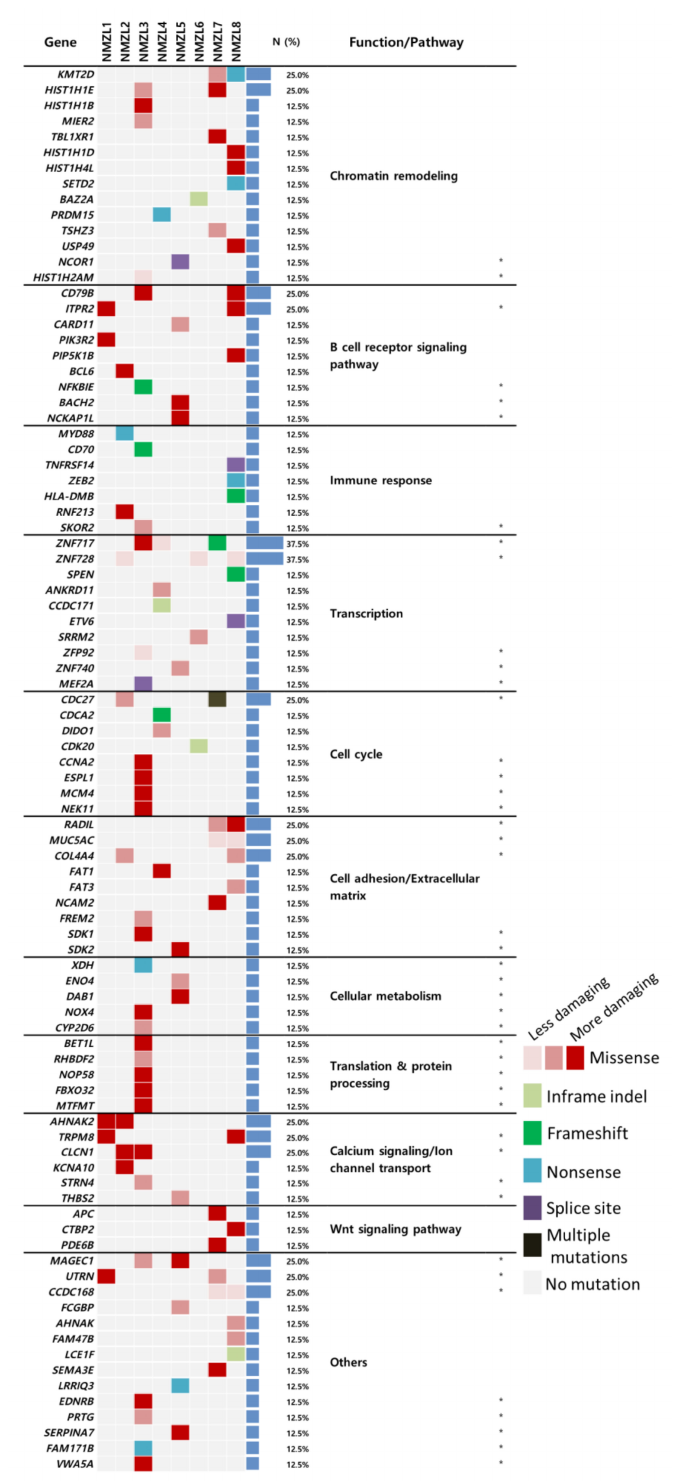
Figure 1. Mutational landscape of nodal marginal zone lymphoma (NMZL). A total of 92 candidate NMZL genes (CNGs) were grouped according to their functional relevance. Consistent with previous reports on the genetics of NMZL, genes related to chromatin remodeling and the B-cell receptor (BCR)-signaling pathway were the most frequently mutated. Other genes, presumably related to the immune response, transcription, and cell cycle were also found to be altered in NMZLs (asterisk: novel genes with mutations not previously found in